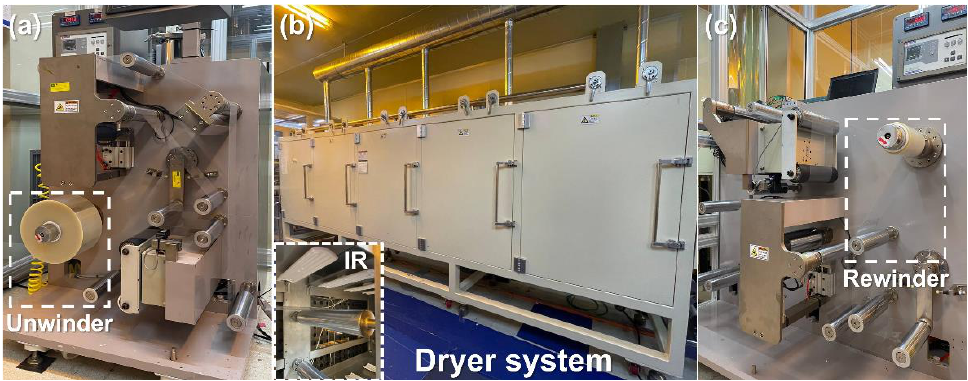
Figure 2. Roll-to-roll manufacturing system: ( a ) unwinding section; ( b ) dryer system with air and infrared (IR) heating system; ( c ) rewinding section.